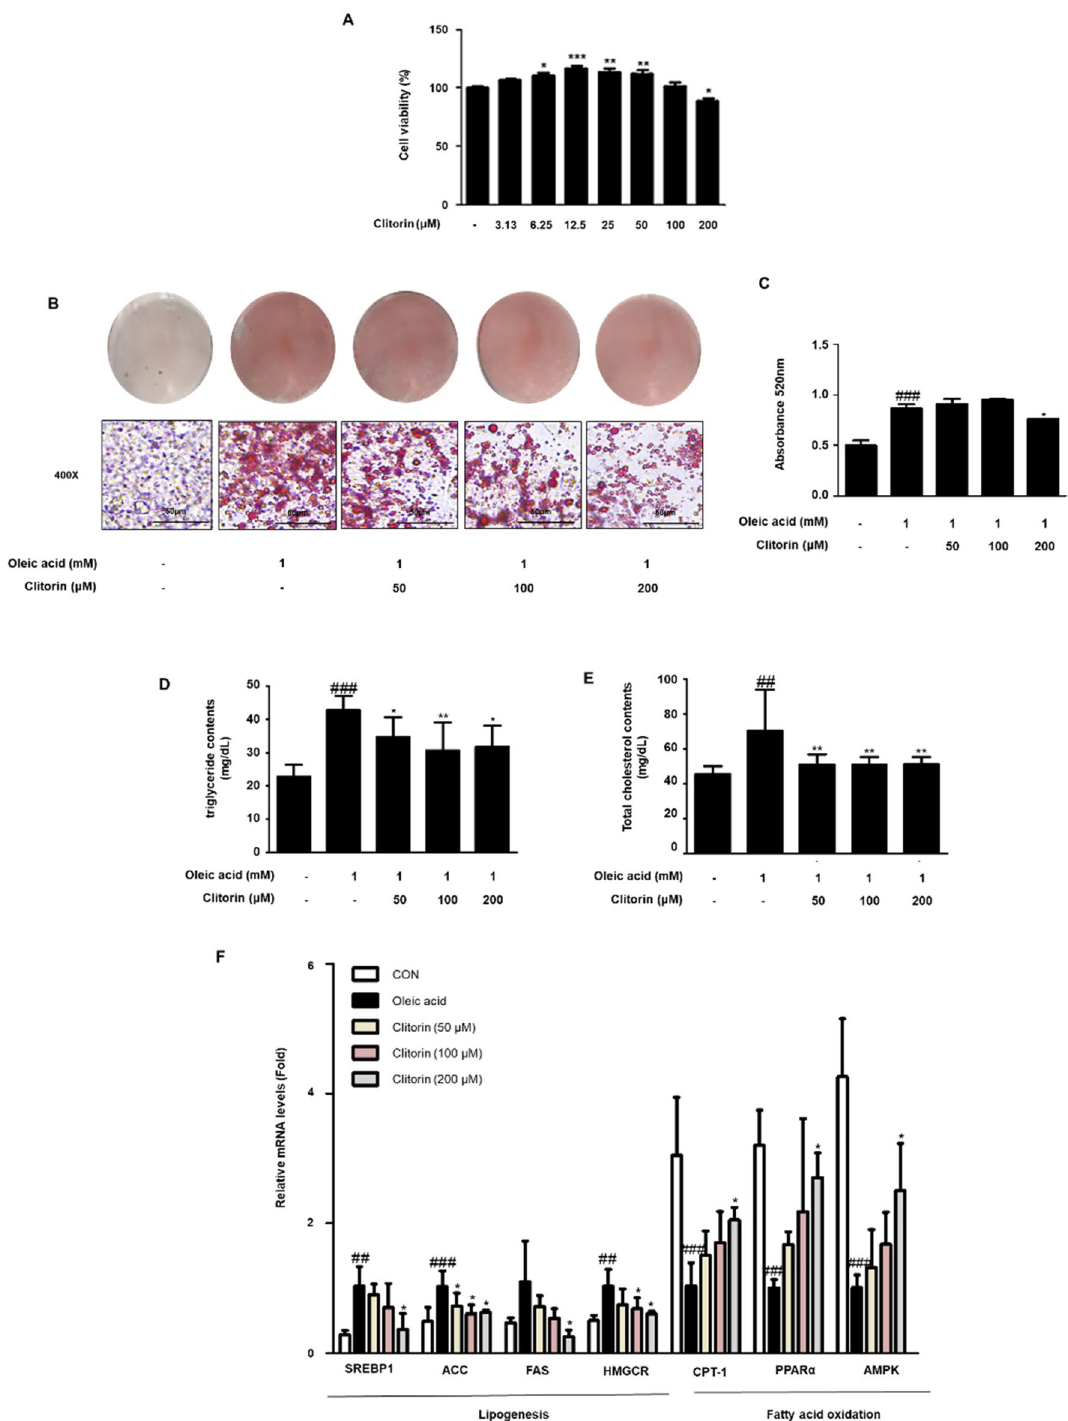
Figure 5. Effect of clitorin on oleic acid-induced lipid accumulation in HepG2 Cells. ( A ) Cell viability was evaluated in HepG2 cells treated with clitorin. ( B ) The lipid accumulation was determined by Oil Red O staining. Images are shown at an original magnification of 400 × . The scale bar is 50 µm. ( C ) The lipid content was quantified by measuring absorbance. The levels of secreted ( D ) triglyceride and ( E ) total cholesterol in HepG2 cells were determined using enzymatic methods. The mRNA levels of ( F ) SREBP1 , ACC , FAS, HMGCR, CPT-1 , PPARα , and AMPK were determined using qRT-PCR analysis. The values are represented as mean ± S.D of three independent experiments. ## P < 0.01 and ### P < 0.001 vs. non-treated cells; *P <